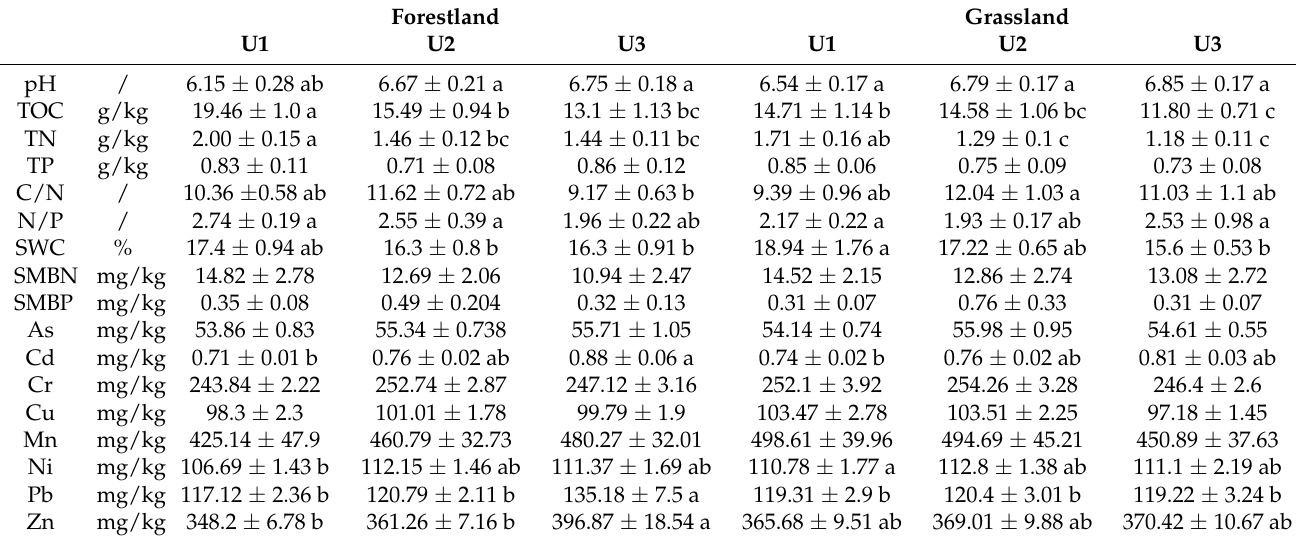
Table 1. Soil properties in forestland and grassland along the rural-suburban-urban gradient (mean ± SE, n = 6). Forestland